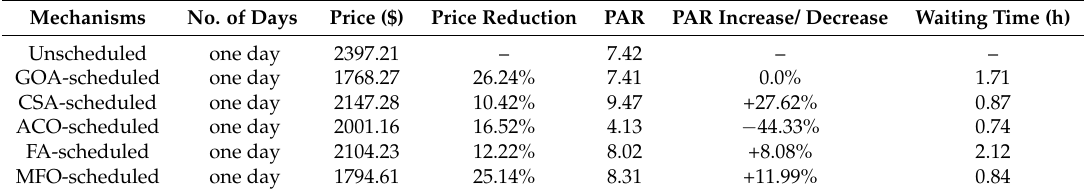
Table 2. An evaluation of the anticipated algorithm for appliances scheduling in terms of unscheduled load and scheduled load with GOA, CSA, ACO, FA and MFO algorithms.